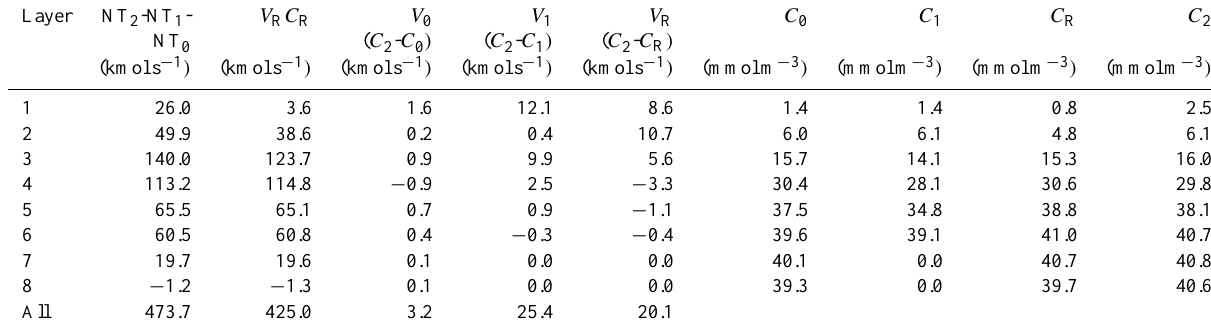
Table 3. Budget of nitrate transport (kmols − 1 ) for each isopycnal layer between sections TK, OK-W, and ASUKA-N. Layer NT 2 -NT 1